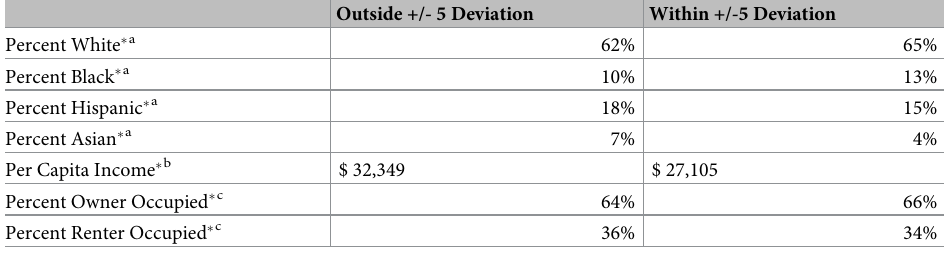
Table 5. Demographic and socio-economic characteristics of uncertain